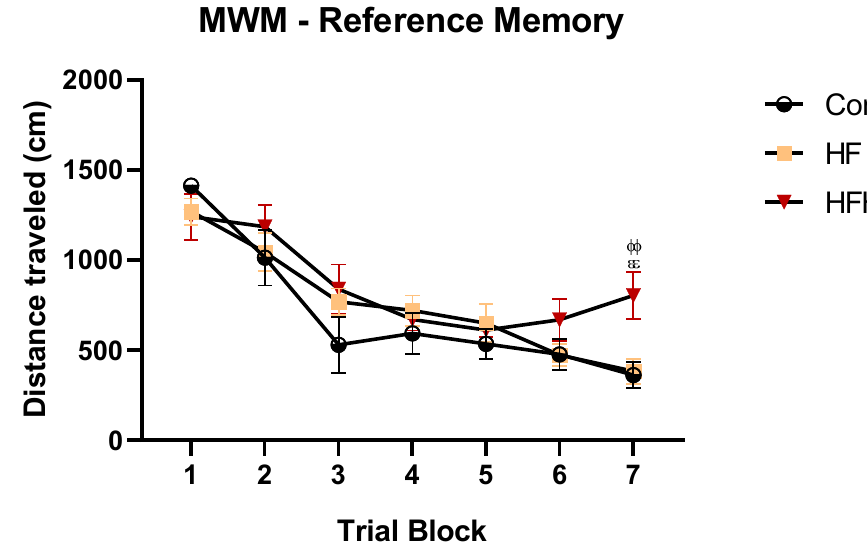
Figure 5. HFHS rats exhibit spatial learning and memory impairments. The graph shows the mean ± SEM total distance traveled to find the hidden platform for each block of trials in the Morris water maze. HFHS rats revealed impaired performance compared to HF and controlled animals in the last trial blocks. φφ p < 0.01 HFHS versus controls; εε p < 0.01 HFHS versus HF group.